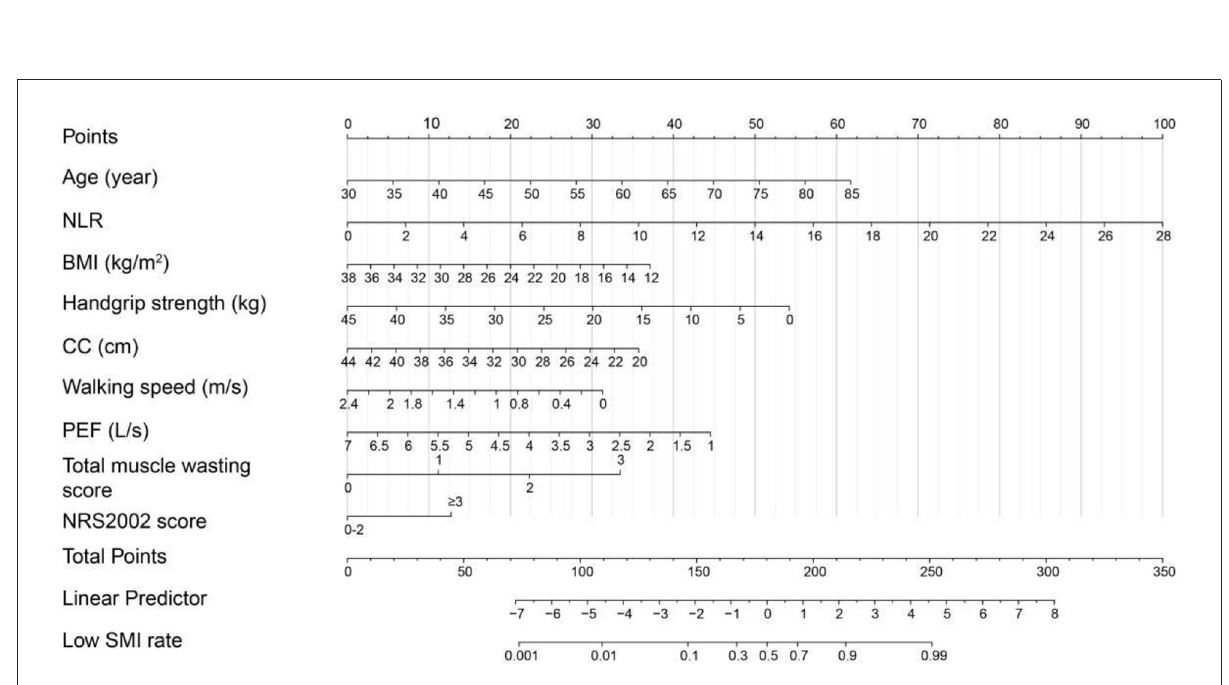
FIGURE3 The nomogram for predicting low SMI based on the training cohort ( n =